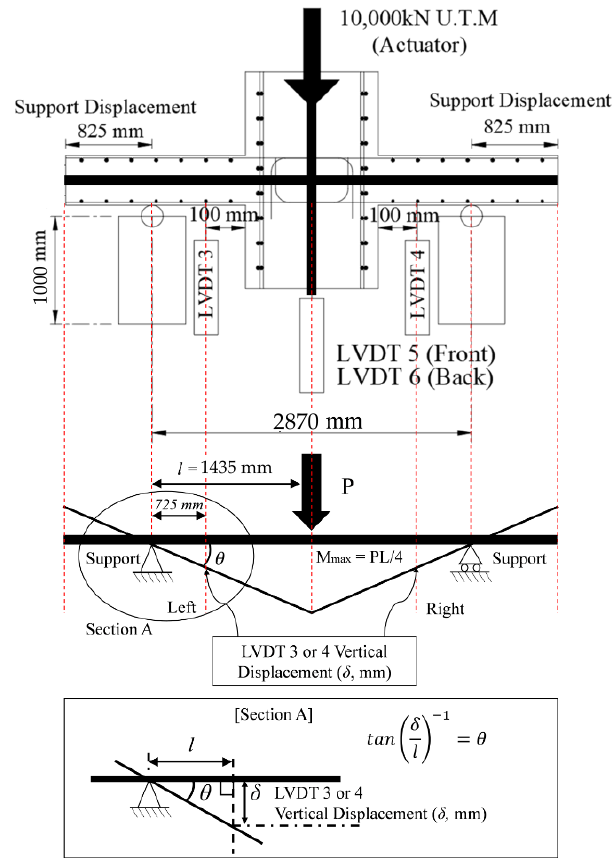
Figure 14. Comparison of load – displacement relationships (NS, OS, and TS specimen). Materials 2021 , 14 , x FOR PEER REVIEW Table 11. Result of load – displacement.